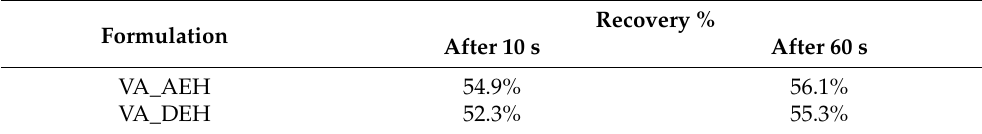
Table 2. Flow recovery of three-interval thixotropic test with different shear rate.